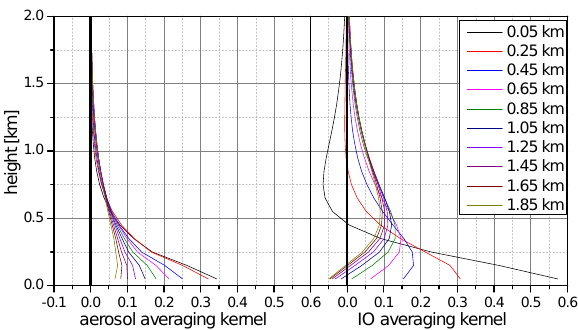
Fig. 2. Measured (squares) and simulated (crosses) O 4 dSCDs (top) Fig. 2: Measured (squares) and simulated (crosses) O 4 dSCDs (top) and IO dSCDs (bot- and IO dSCDs (bottom) for 14 October 2009. The colour coding tom) for October 14, 2009. The colour coding indicates the elevation angles. indicates the elevation angles.